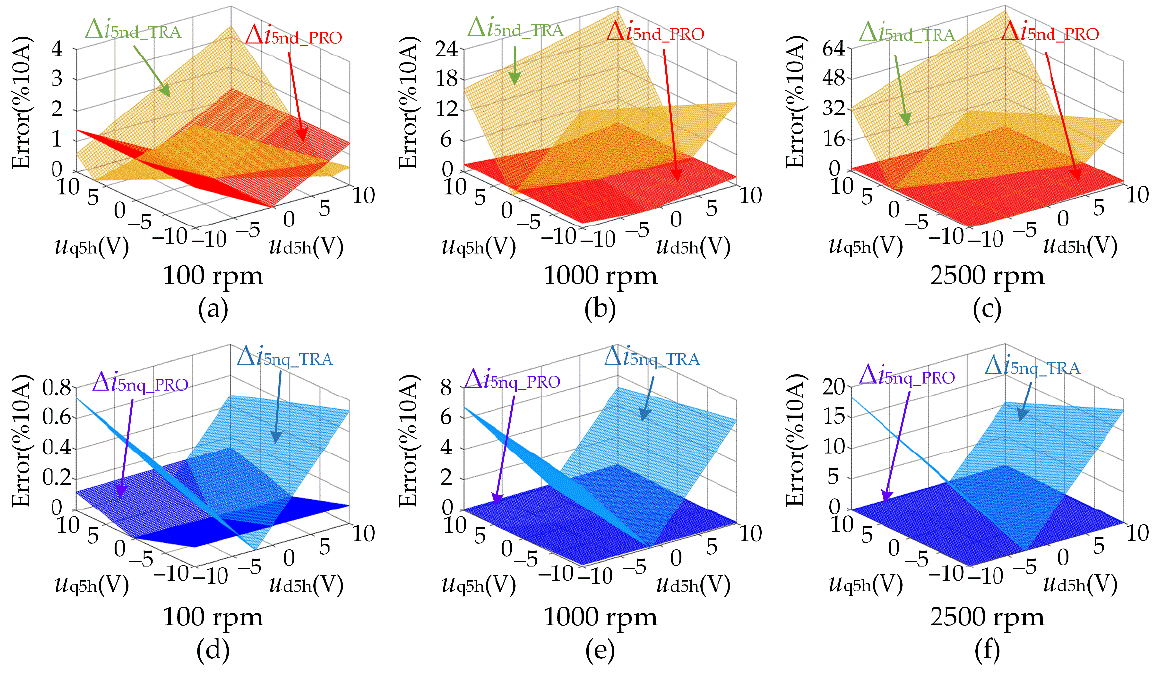
Figure 10. Errors of forced components of DPC model and IDPC model at different motor speeds. ( a ) Forced component of d-axis current harmonic at 100 rpm; ( b ) forced component of d-axis cur- rent harmonic at 1000 rpm; ( c ) forced component of d-axis current harmonic at 2500 rpm; ( d ) forced component of q-axis current harmonic at 100 rpm; ( e ) forced component of q-axis current harmonic at 1000 rpm; and ( f ) forced component of q-axis current harmonic at 2500 rpm.